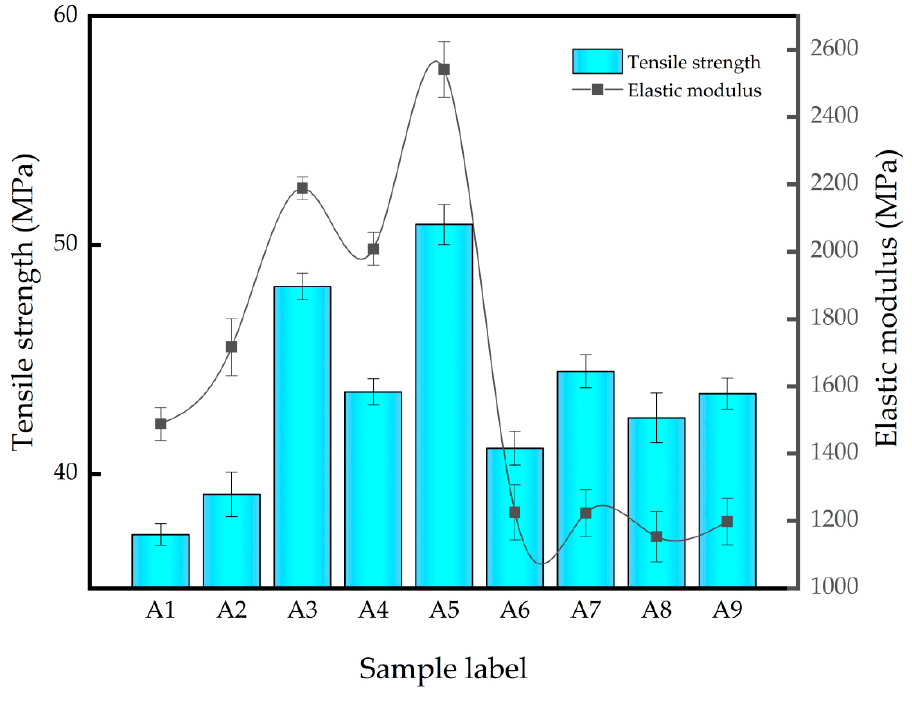
Figure 1. Tensile strength and elastic modulus of different PLA/PBS composites.